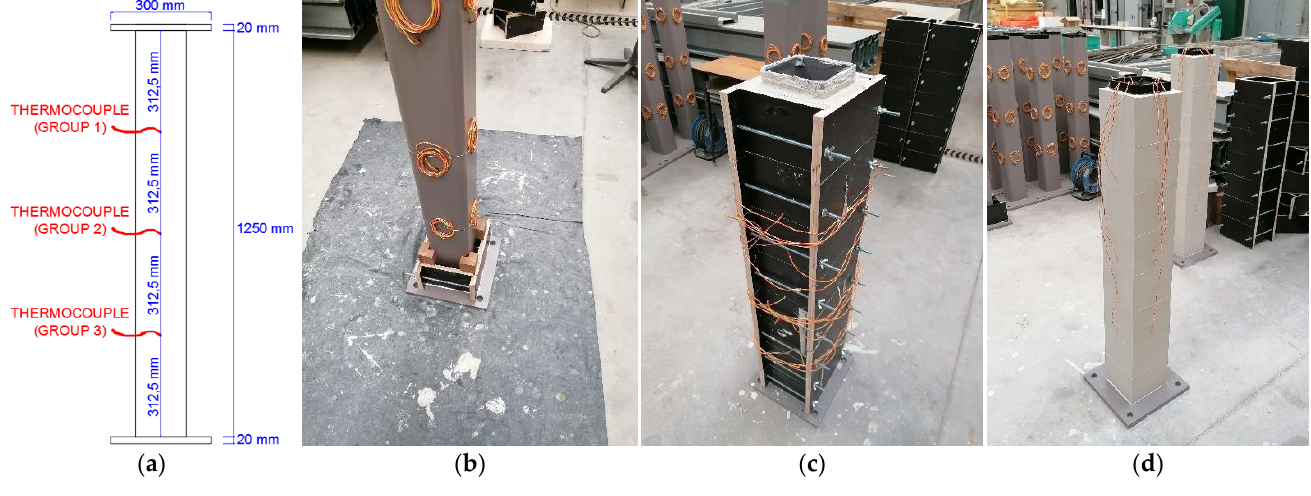
Figure 6. Distribution of thermocouples ( a ) and fabrication of specimens, preconcreting ( b ), con- creting on the short steel columns ( c ), and concrete specimen without formwork ( d ).